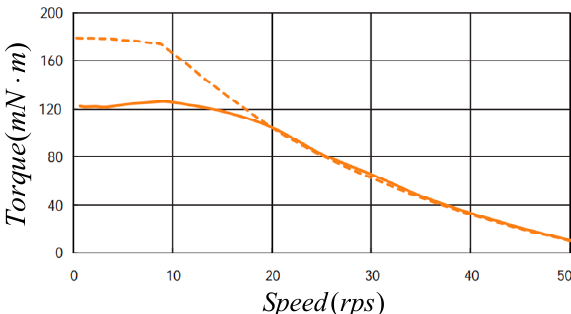
Figure 11. Torque curve of the drive motor.